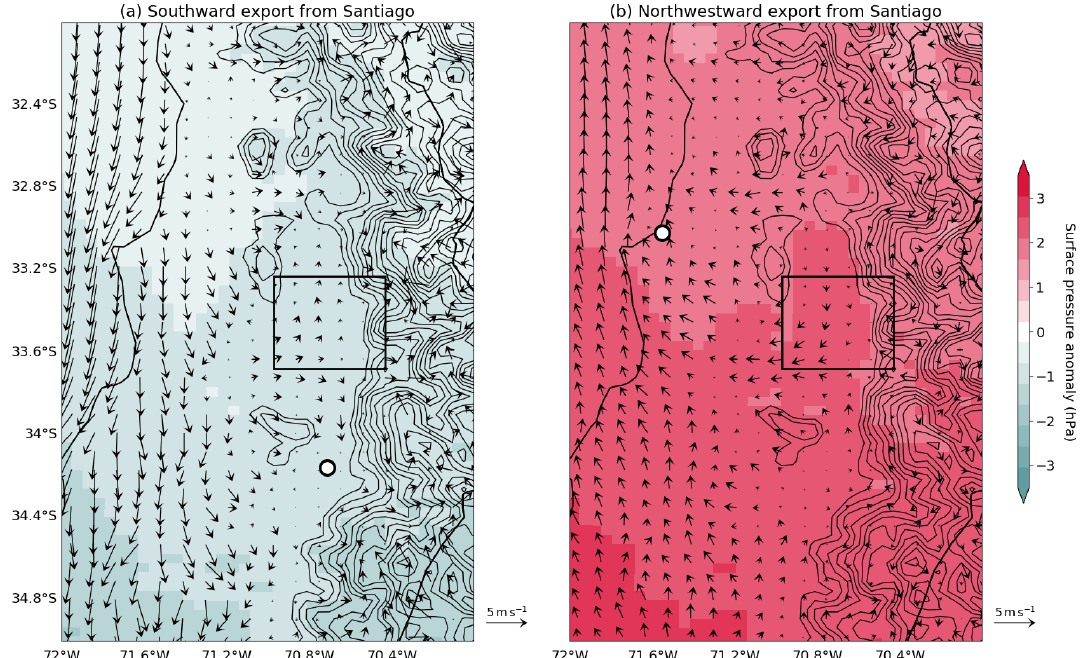
Figure A4. (a) Composite of surface wind (arrows) and pressure (color map) anomalies, with respect to the wintertime average, for hours of southward transport episodes, defined as hours when the concentration of PM 2 . 5 from Santiago (black rectangle) in Rancagua (white dot) is greater than or equal to its 90th percentile for the period. Contours show terrain elevation in excess of 1000m every 250m. Panel (b) is the same as panel (a) but during hours of northwestward transport, defined in the same manner but with respect to concentrations in Viña del Mar (white dot).